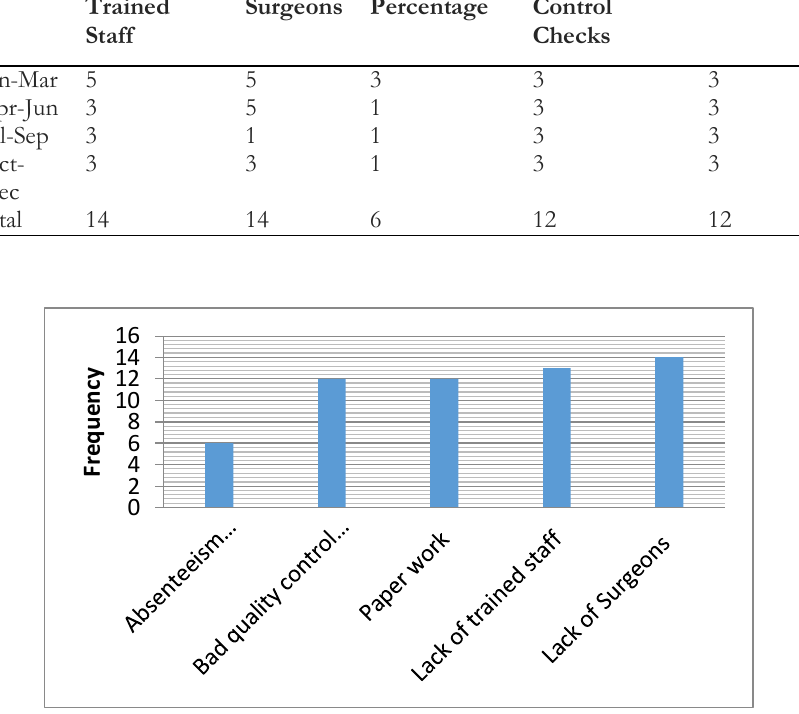
Fig. 13. Chart for the causes